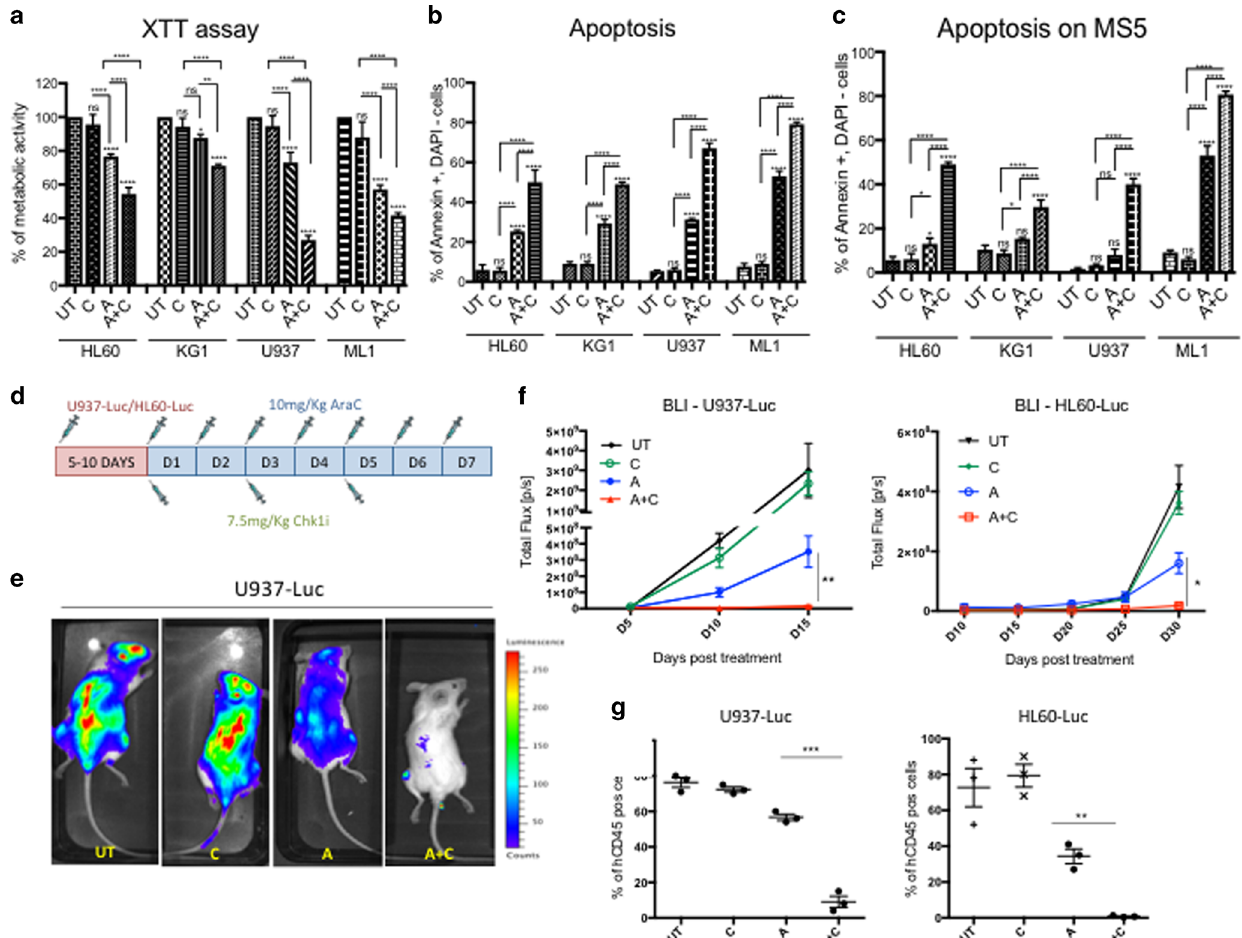
Fig. 1 CHK1i enhances the cytotoxicity of AraC in different AML cell lines in vitro and in vivo. a Percentage of cell metabolic activity in four AML cell lines after 1-day treatment with AraC (A) and AraC+CHK1i (A+C) normalized on the untreated (UT) control. (UT n = 3; C n = 3; A n = 3; A+C n = 3). b Percentage of apoptosis with the same cell lines and treatment conditions as in a . (UT n = 3; C n = 3; A n = 3; A+C n = 3). c Percentage of apoptotic cells as in b , but the cell lines were seeded on an irradiated MS5 stromal layer. (UT n = 3; C n = 3; A n = 3; A+C n = 3). d Treatment regimen for AraC and CHK1i with U937-Luc and HL60-Luc, in vivo. e In vivo bioluminescence imaging (BLI) 15 days after Luc-marked cell injection under different treatment conditions (upper panel U937; lower panel, HL60). f Kinetics of tumor proliferation by BLI signal quanti fi cation, up to 15 days after U937-Luc injection (left panel) and 30 days after HL60-Luc injection (right panel). n = 3 animals per cohort. g Percentage of U937-Luc cells in the bone marrow of the transplanted mice 3 days post treatment (D15) (left panel) and HL60-Luc (D30) (right panel). Each dot represents an individual mouse. (UT n = 3; A n = 3; A+C n = 3). * p < 0.05, ** p < 0.001, *** p < 0.001, **** p <